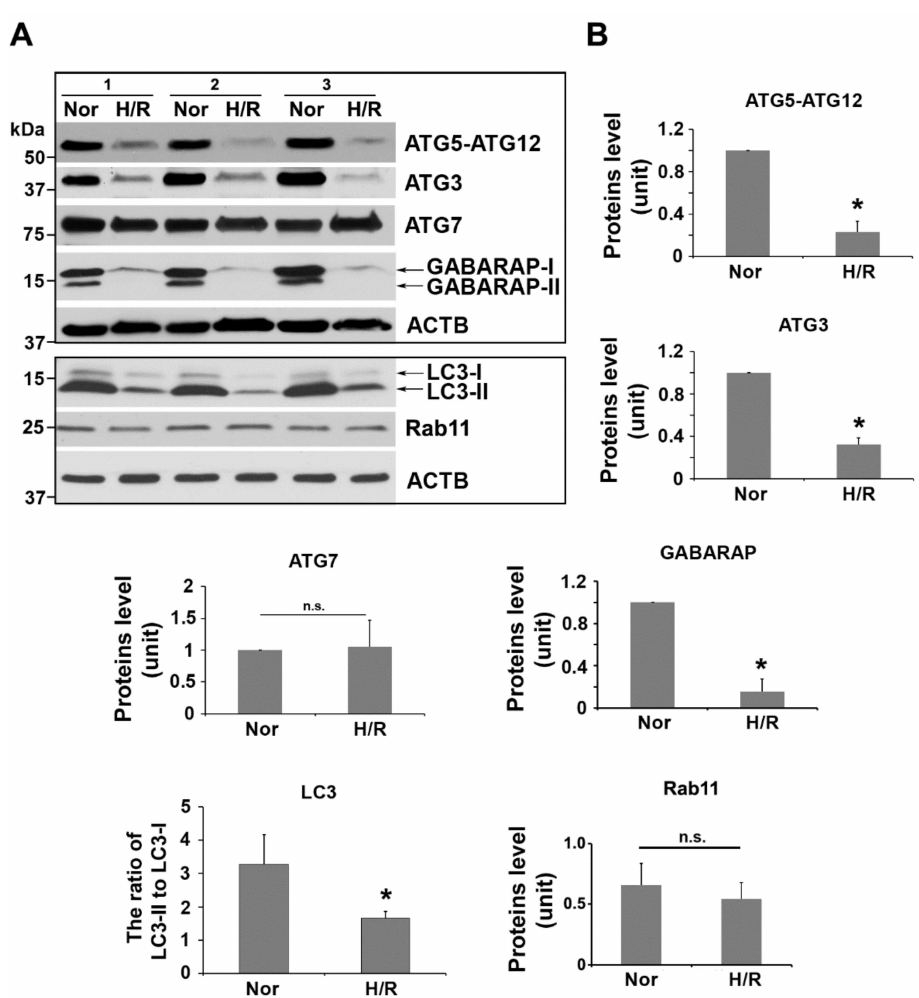
Figure 2. H/R condition disturbs Atg12–Atg5, LC3/GABARAP conjugation systems, and their related regulators in PHTs. ( A ) Western blots of indicated molecules in normoxia (Nor)- and H/R- treated PHTs. ( B ) Quantification of the intensity of bands shown in ( A ). Data are expressed as mean ± SEM and analyzed by a Student’s t -test ( n = 3). *: p < 0.05, n.s.: not statistically